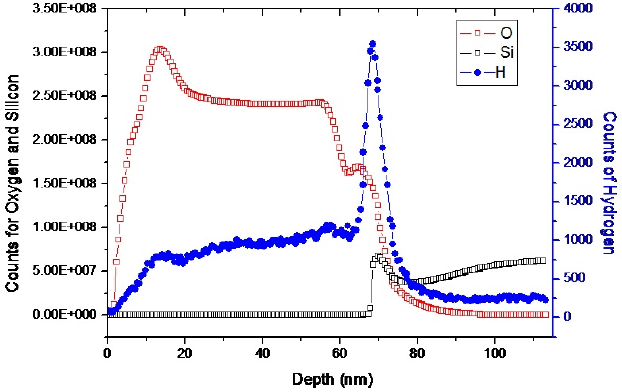
Figure 2. SIMS (secondary ion mass spectrometry) depth profiles of oxygen, silicon and hydrogen.